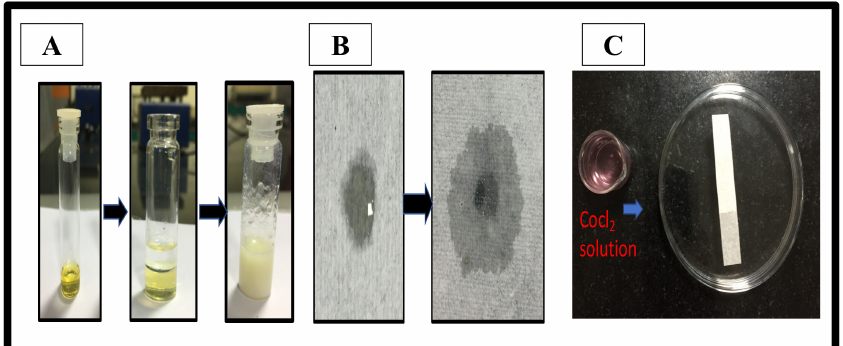
Figure 4. ( A ) Dilution test, ( B ) filter paper test, and ( C ) cobalt chloride